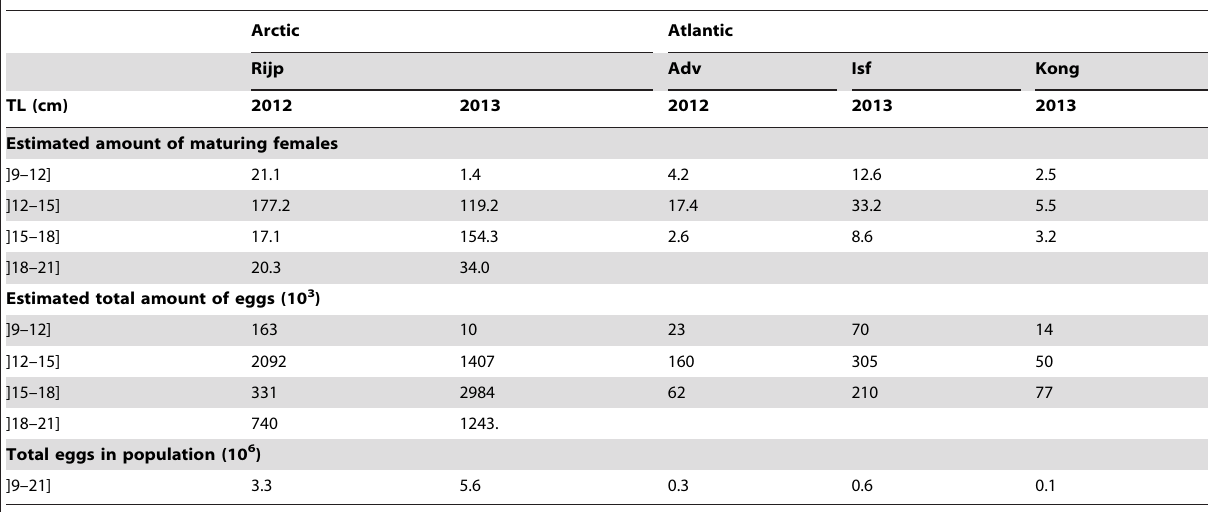
Table 4. Population fecundity